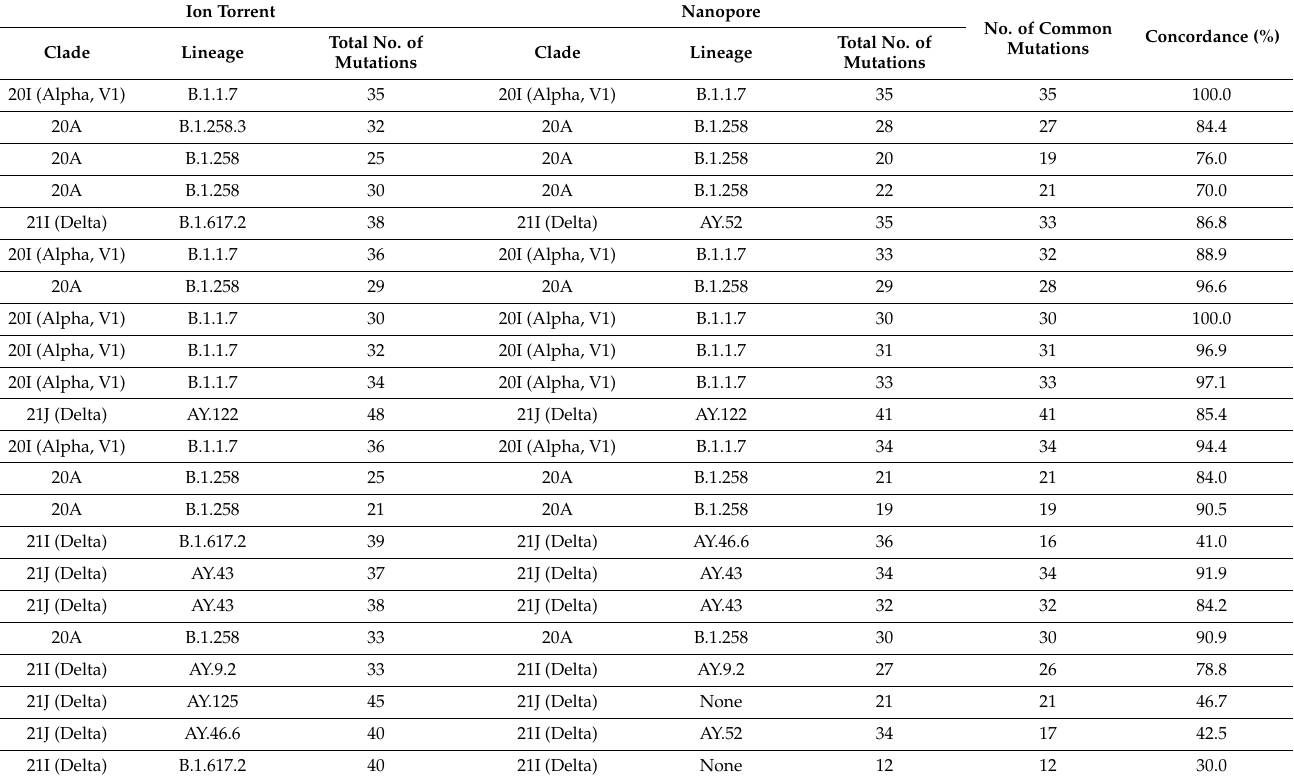
Table 2. Comparison of the results generated by Ion Torrent and Nanopore